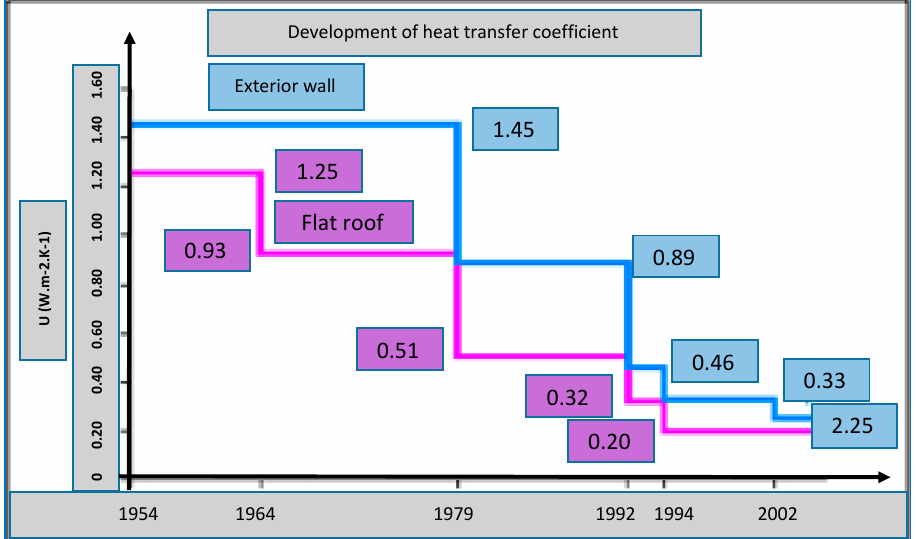
Figure 4. Development of thermal protection equirements in the years 1954 to 2002 (source photo: